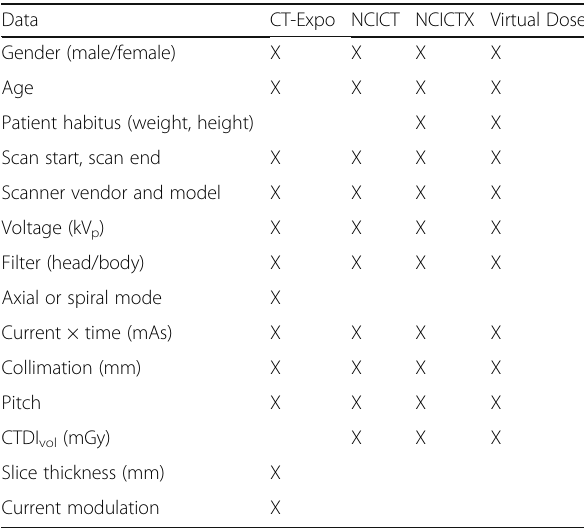
Table 1 Input data required by the software CT-Expo, NCICT, NCICTX, and Virtual Dose to estimate the organ dose for a CT study Data CT-Expo NCICT NCICTX Virtual